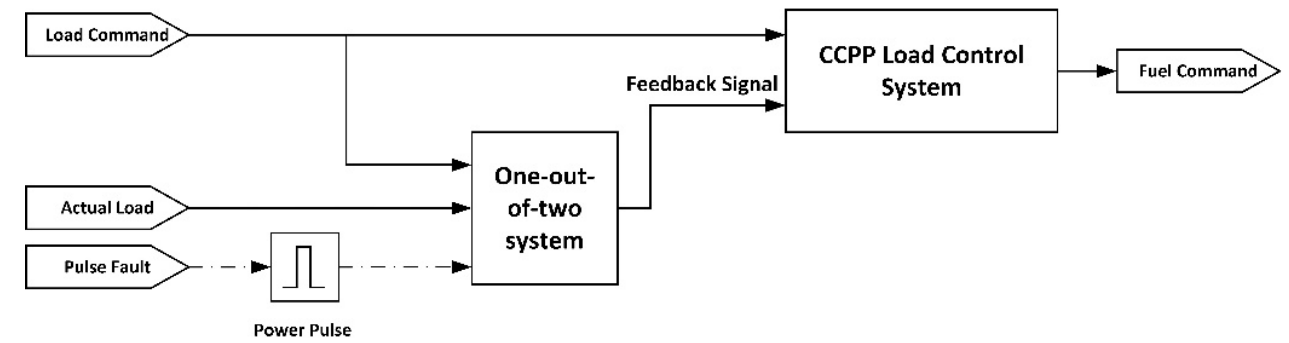
Figure 10. Fault isolation scheme for pulsing faults in single-shaft CCPP.